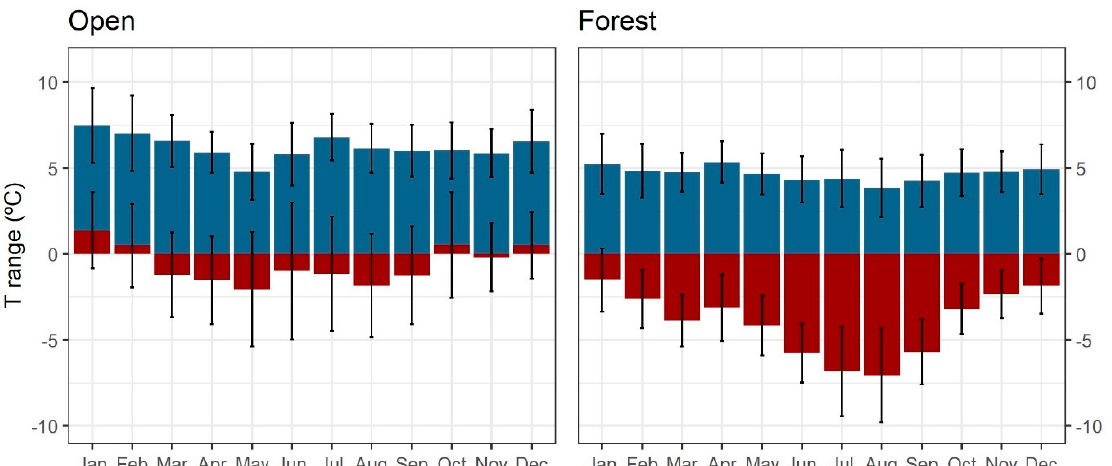
Figure 13. Monthly offsets of Tn (in blue) and Tx (in red) in the soil of open and forested habitats along 2100 m of the elevation of the PNOMP. Offsets were calculated as the difference between micro- and macro-temperatures, as recorded by in situ sensors and estimated by WorldClim, re- spectively.